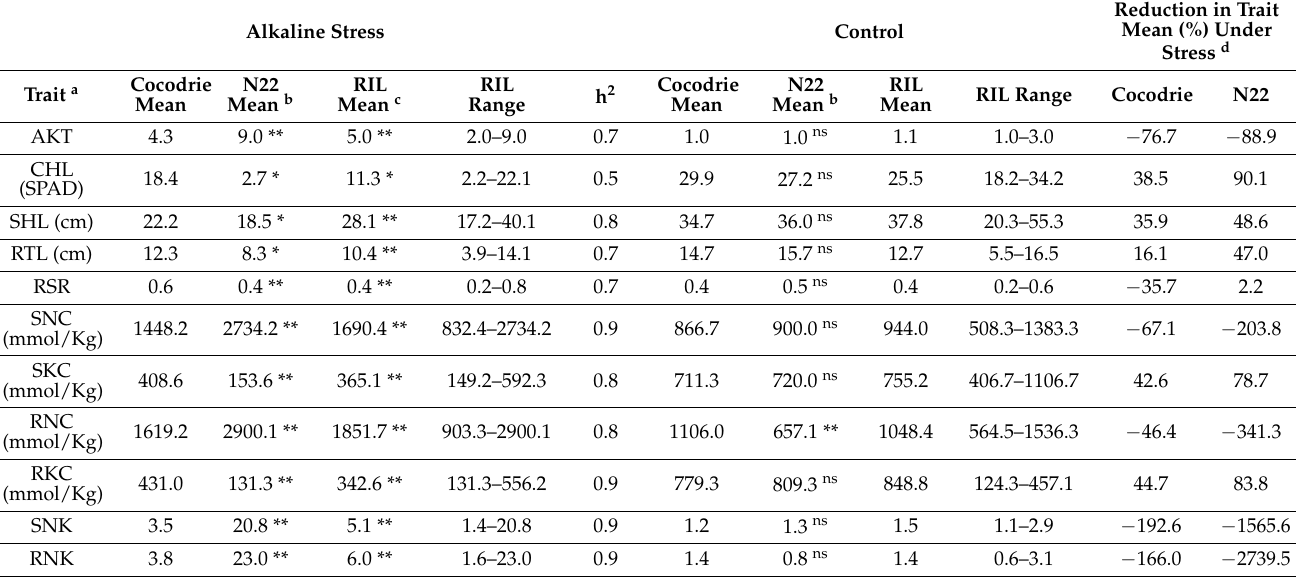
Table 1. Mean phenotypic performance of the Cocodrie x N22 RIL population for various morpholog- ical and physiological traits at the seedling stage, under non-stress or alkaline stress environments. Alkaline Stress Control